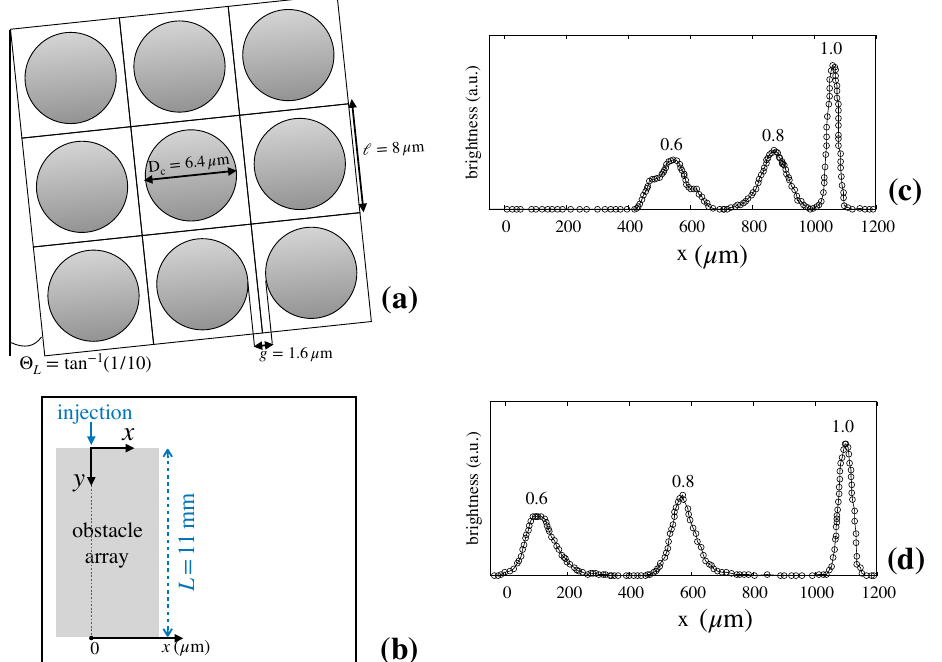
Figure 3. Experimental measures of particle separation efficiency in Huang’s device [6] (see the main text for details). ( a ) lattice geometry; ( b ) reference frame for fluorescence measures. The average flow direction is directed along the y -axis; ( c ) brightness vs. cross-section coordinate x at flowrate 40 µ m/s; ( d ) brightness vs. cross-section coordinate x at flowrate 400 µ m/s. The data reported in ( c ) and ( d ) are taken from Ref.